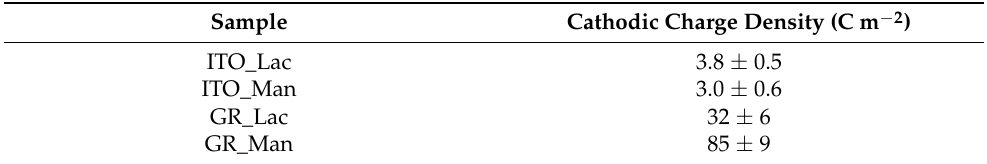
Table 1. Integrated cathodic charge associated with electrografting experiments on the two different substrates used in this work.